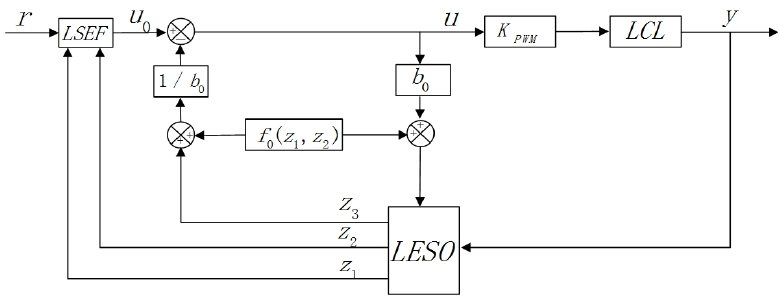
Figure 3. Linear active disturbance rejection control (LADRC) controller with model